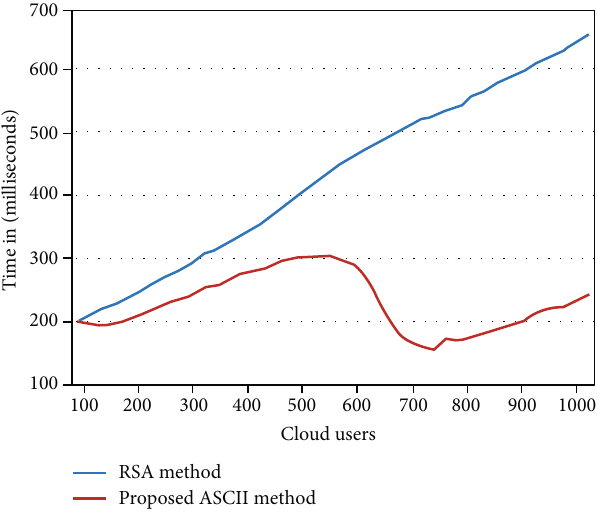
Figure 7: Data encryption accuracy time.